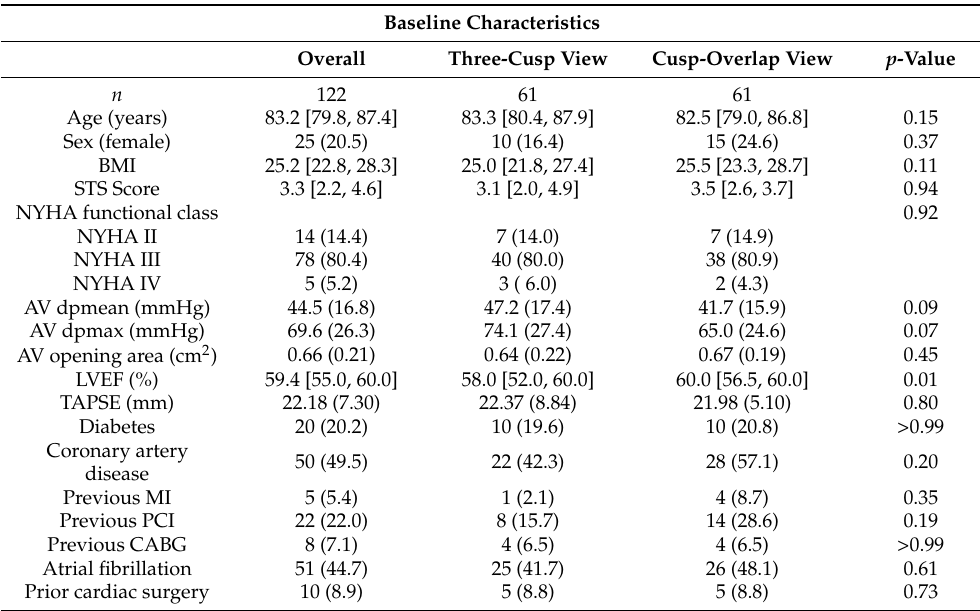
Table 1. Baseline characteristics. This table demonstrates the baseline characteristics of the study